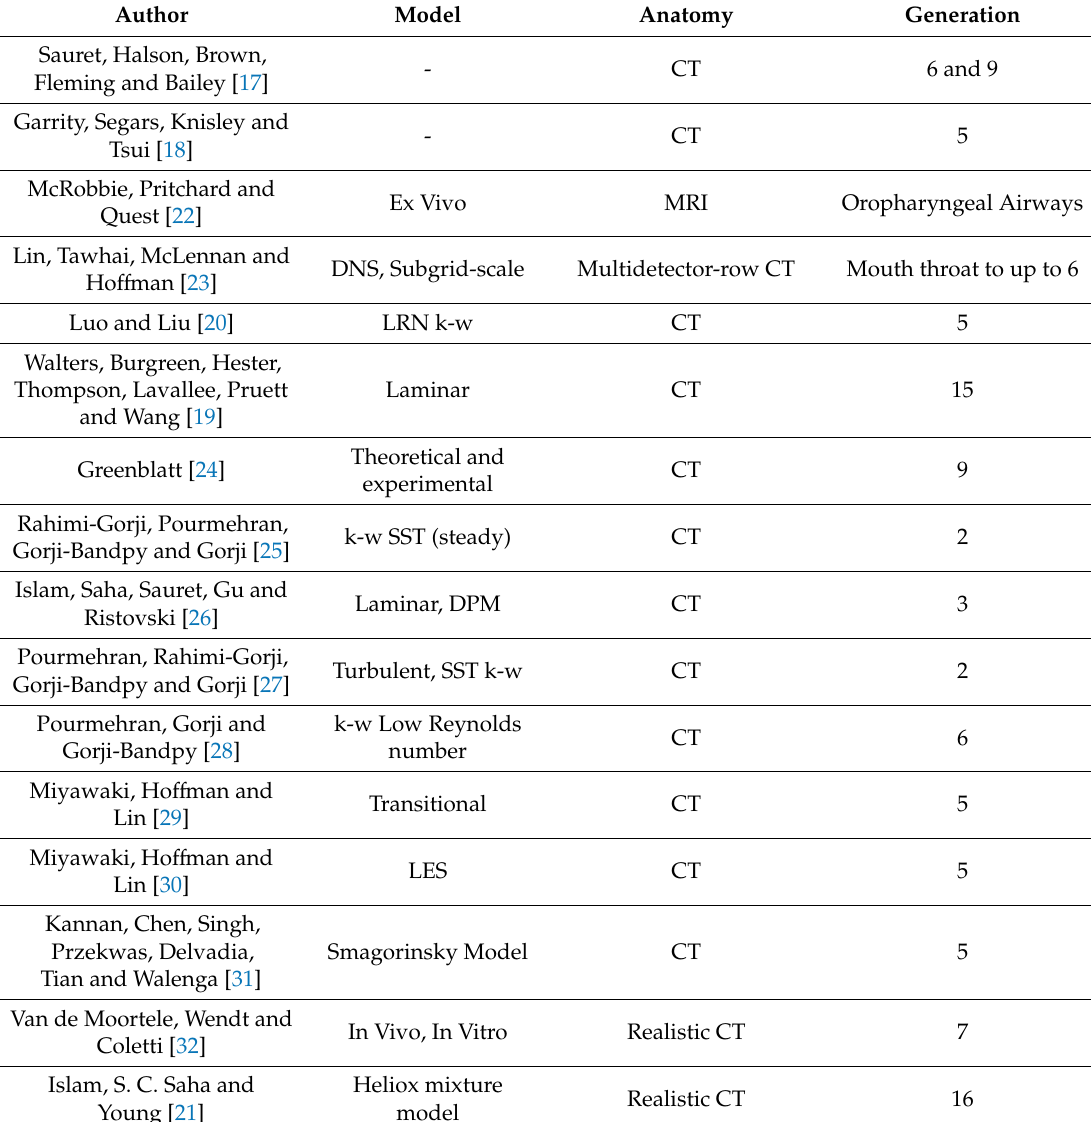
Table 1. List of available anatomical models of lung based on CT / MRI